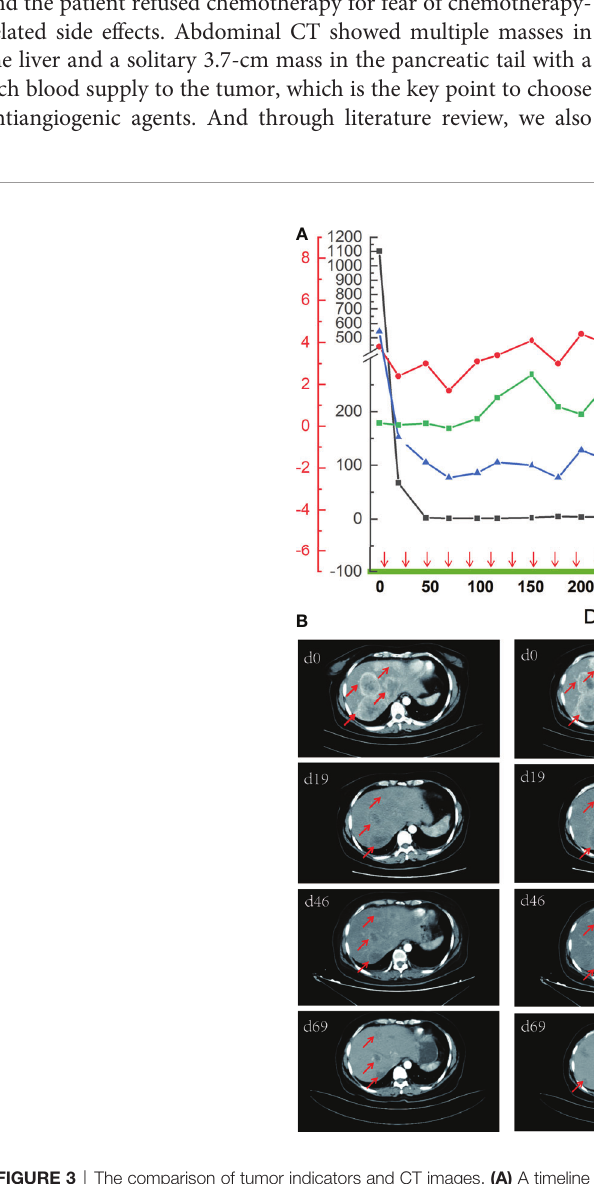
FIGURE 3 | The comparison of tumor indicators and CT images. (A) A timeline outlining the treatment course (lenvatinib 8 mg, orally, qd; and sintilimab 100 mg, intravenous glucose tolerance test, q21d) and changes of laboratory indicators including alpha-fetoprotein (AFP), neutrophils, lactate dehydrogenase (LDH), and eosinophils. (B) Imaging changes of the fi rst four times of evaluation with tumor lesions marked by red